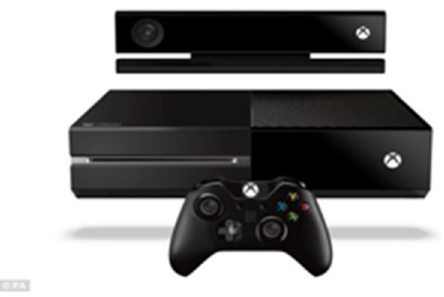
Figure 7. Kinect Sensor (source: https://en.wikipedia.org/wiki/Kinect).